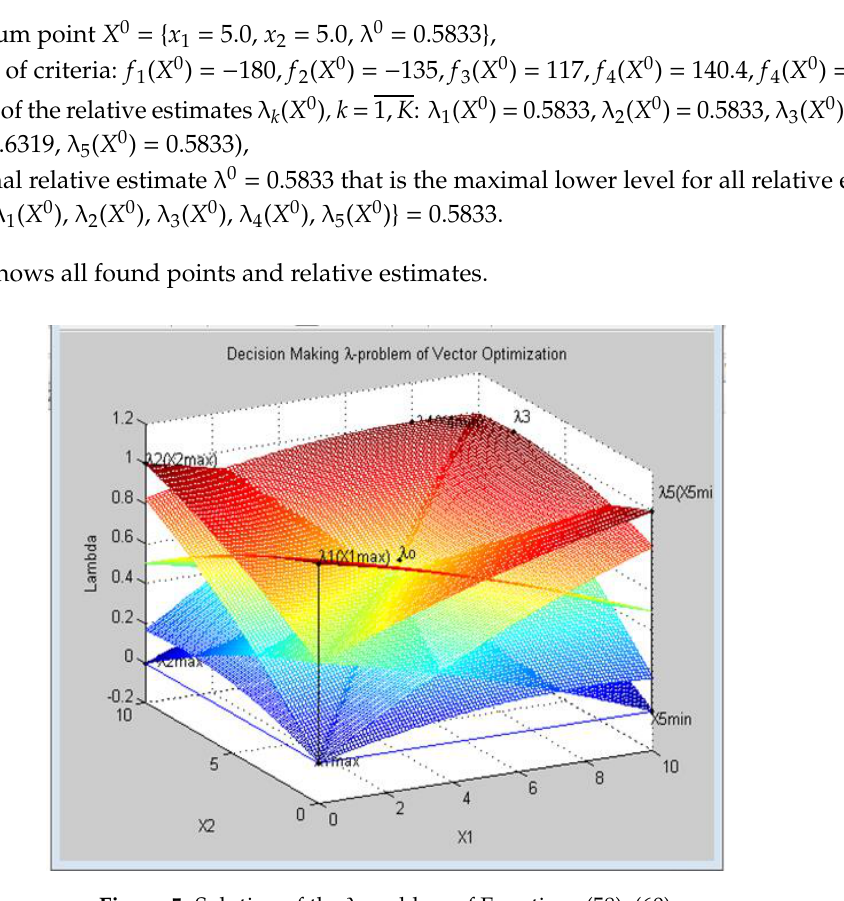
Figure 5. Solution of the λ -problem of Equations (58) – (60).